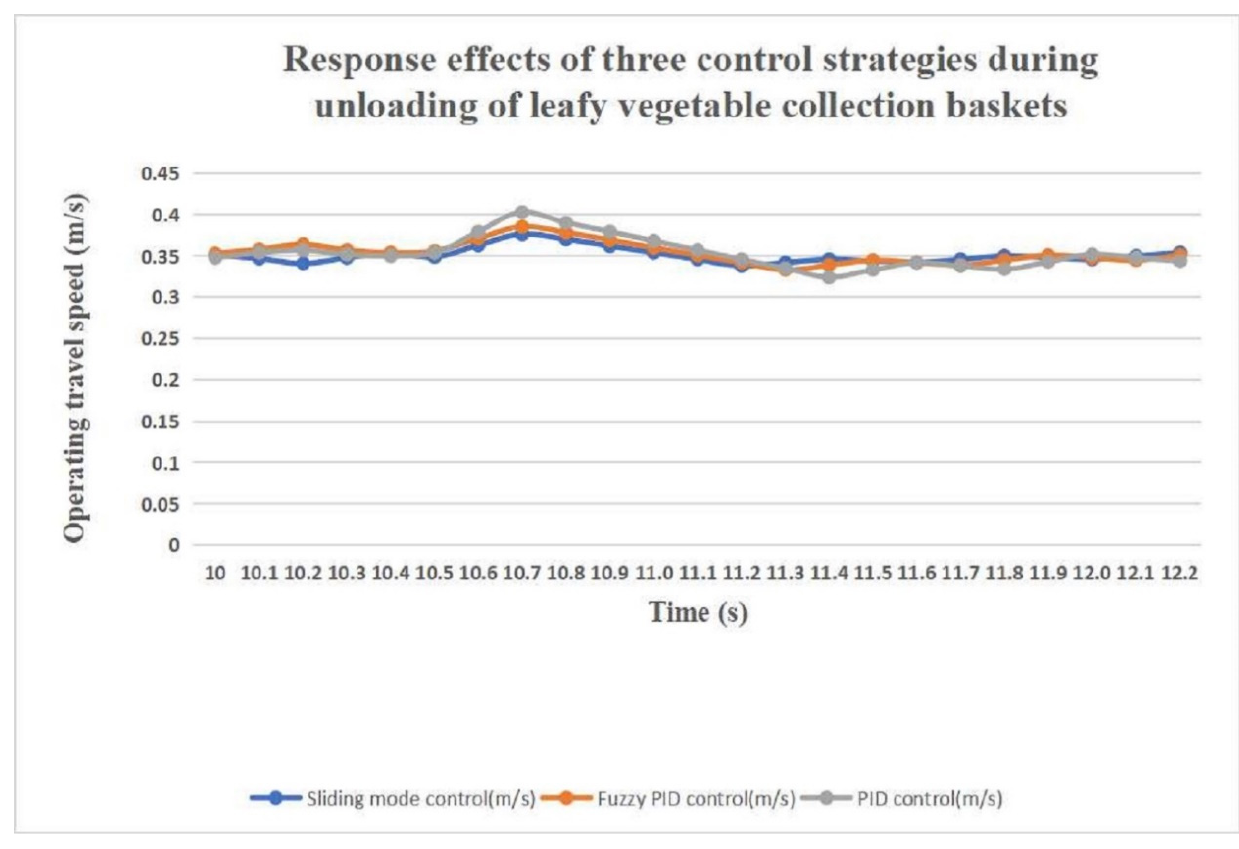
Figure 19. Response effects of three control strategies when the leafy vegetable collection baskets were full and unloaded under smooth operation of the harvester.